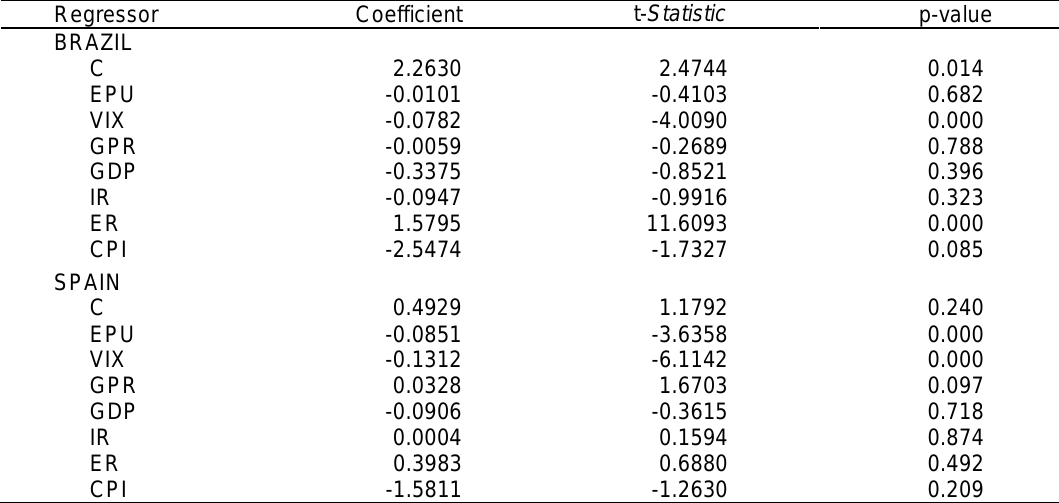
Table 5. Long-term ARDL model coefficients. Regressor Coefficient t-